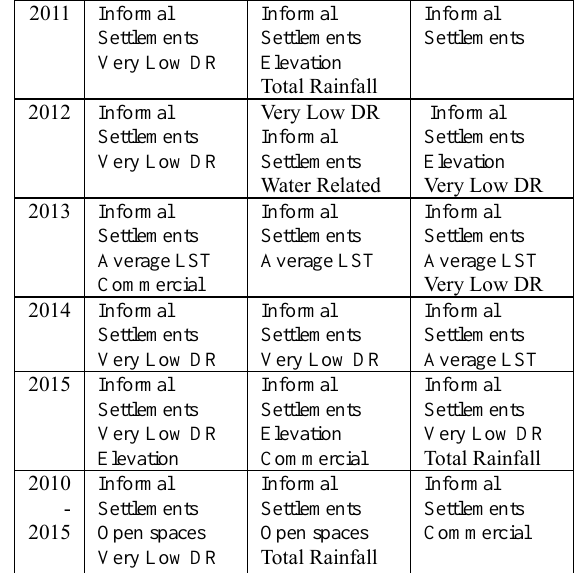
Table 7. Significant Variables of the Quezon City, Cluster 1 and Cluster 2 in each year and whole period, (*DR – Density